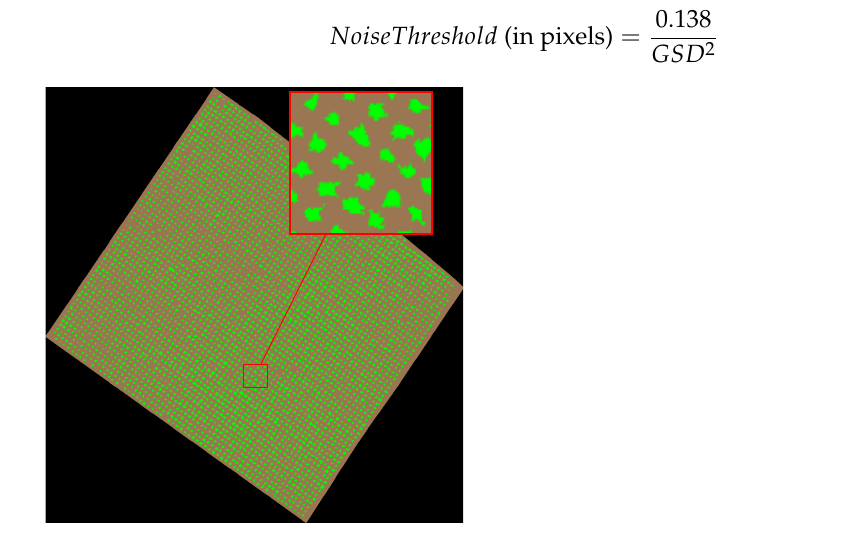
Figure 2. Three segments image: vines (green), soil (brown), and no-data (black).